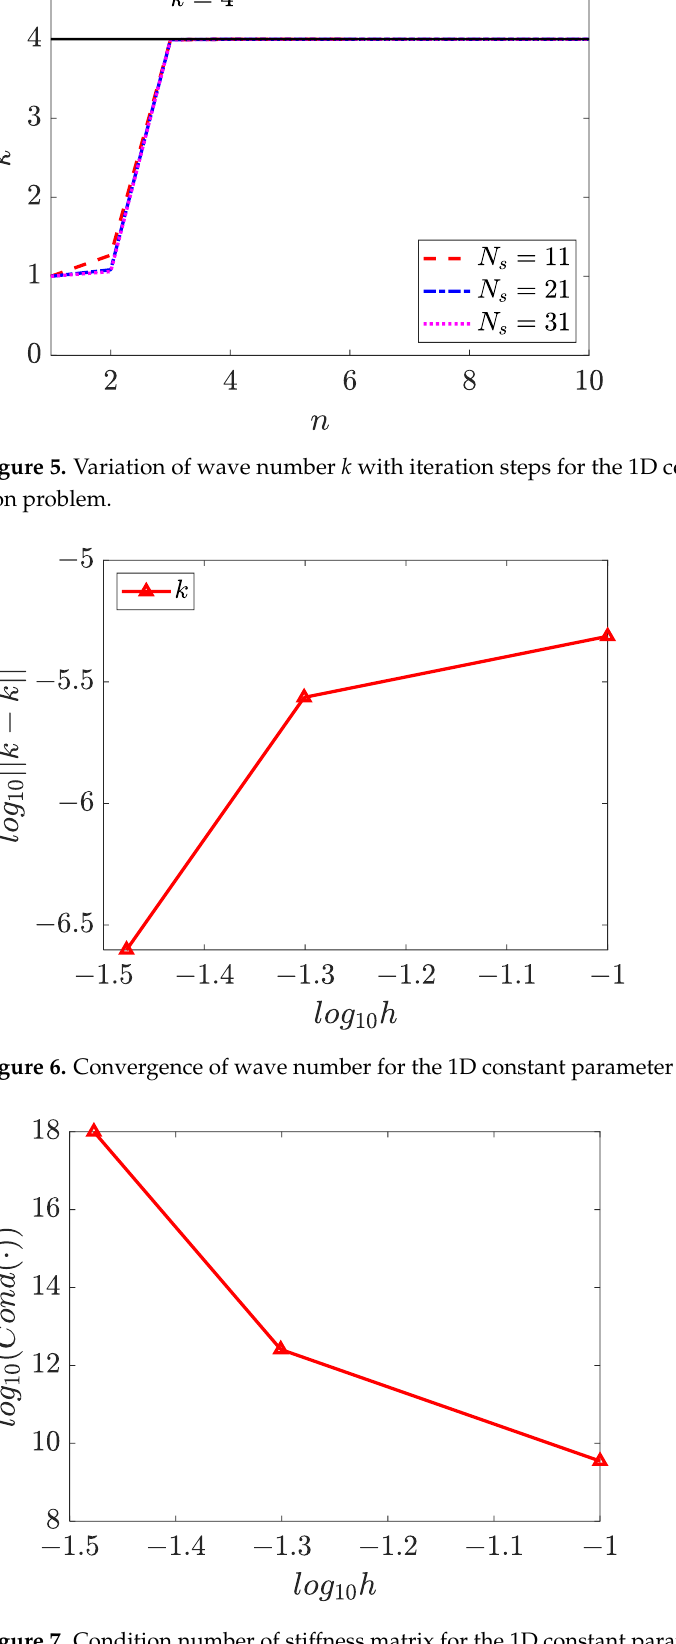
Figure 7. Condition number of stiffness matrix for the 1D constant parameter identification problem. 4.2. Two-Dimensional Inverse Helmholtz Problem of Constant Parameter Identification in Irregular Geometry In this example, we study a two-dimensional (2D) inverse Helmholtz problem in ir- regular domain, as shown in Figure 8.